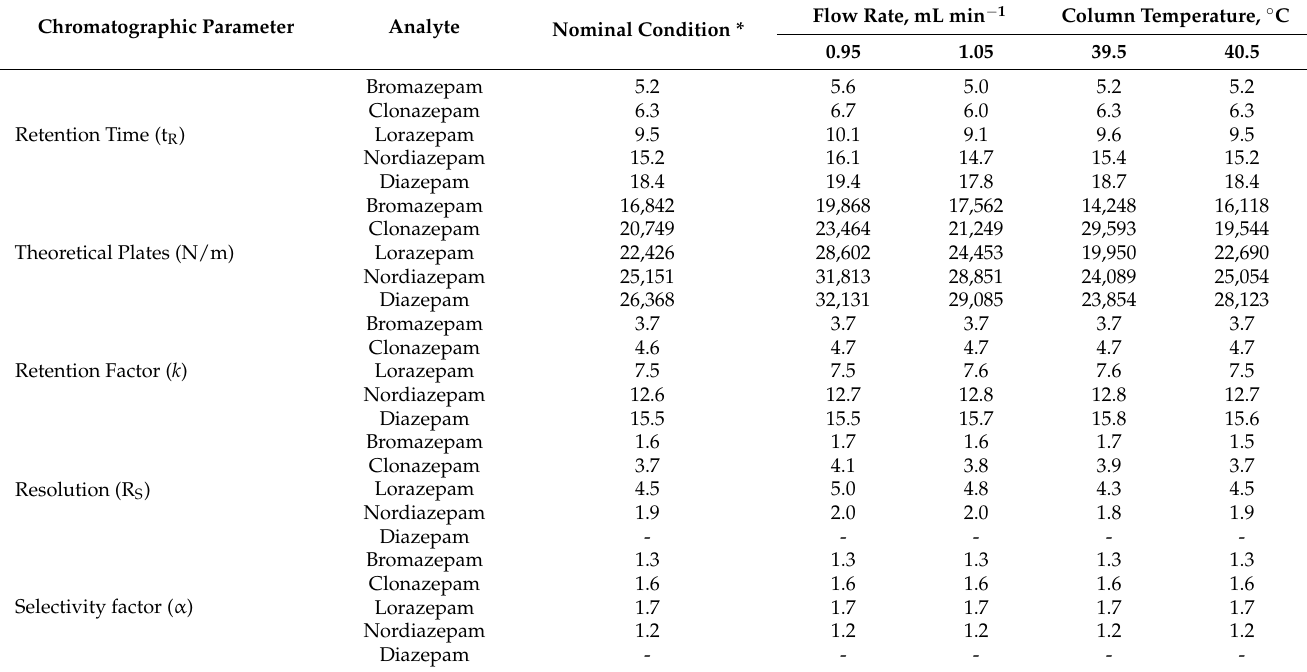
Table 3. Robustness of the selected BZDs under various conditions of flow rate and column